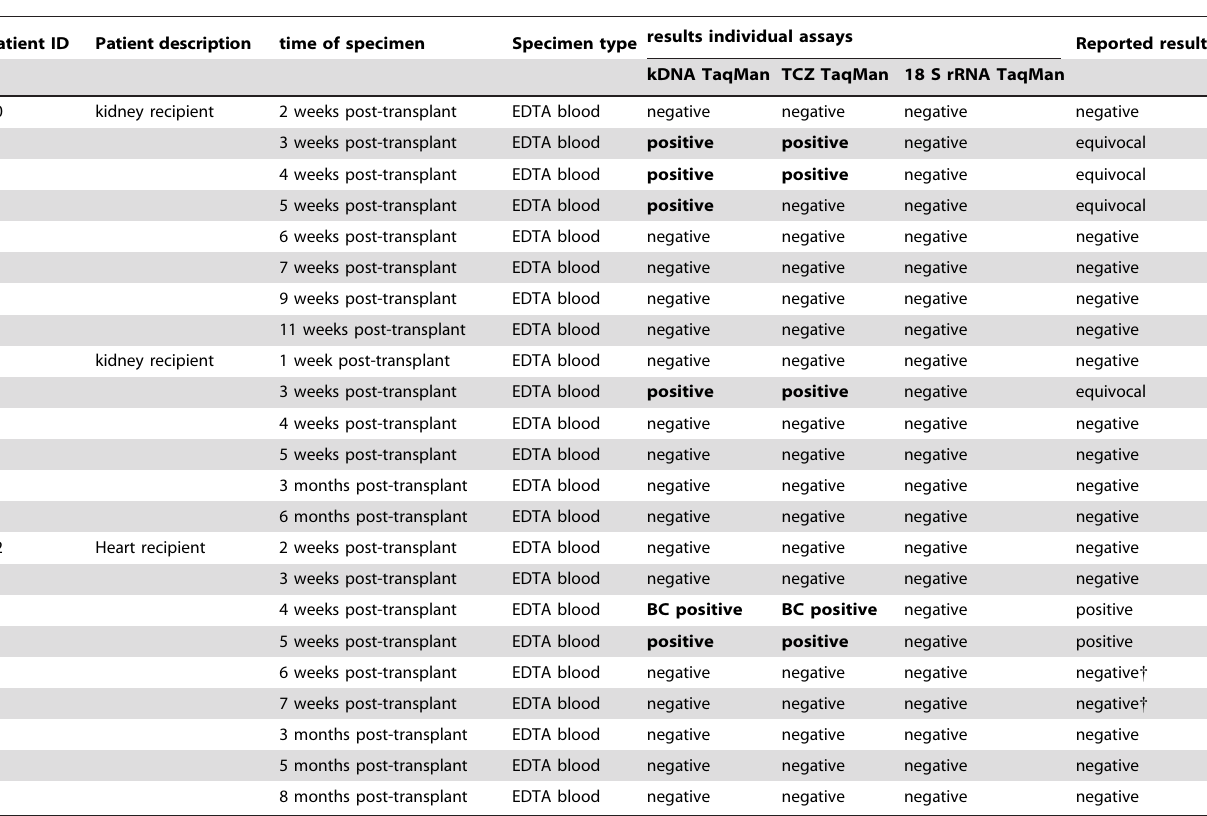
Table 4. Detailed PCR-findings for recipients of organs from donors with suspected/confirmed chronic Chagas disease.